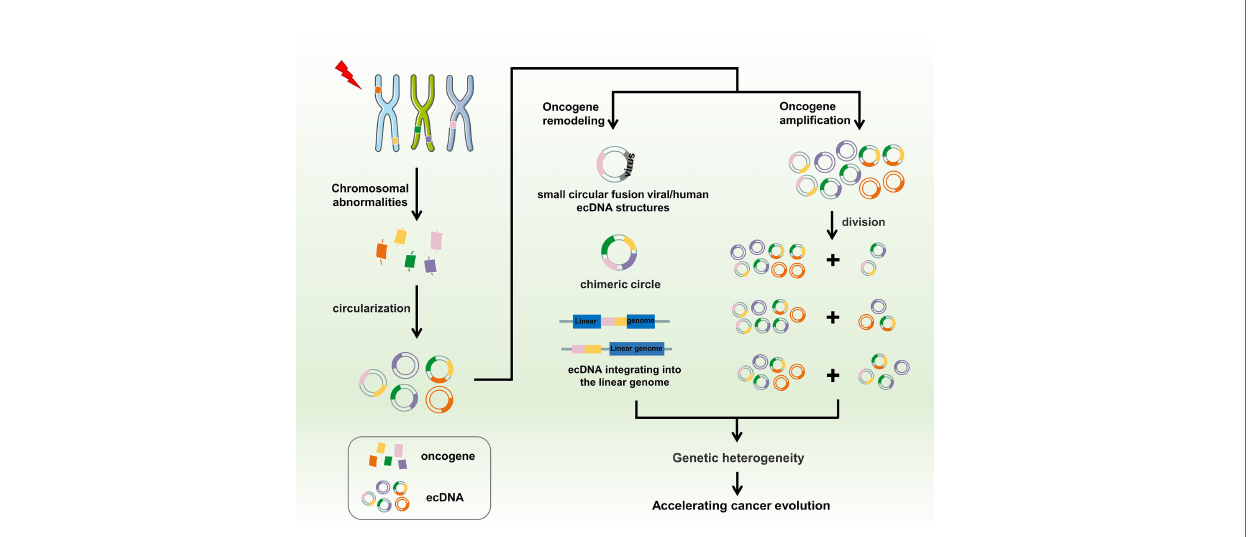
FIGURE 4 | EccDNA accelerates cancer evolution. Chromothripsis, genomic rearrangement, or other possible chromosomal abnormalities may cause DNA fragments to circularize to form eccDNA. EccDNA promotes oncogene remodeling through fusion with human viruses or chimeric circularization and reintegration of eccDNA into the linear genome, whereas ampli fi cation of oncogenes on eccDNA instead of chromosomes leads to higher copy numbers of these oncogenes in tumors. Moreover, eccDNA is randomly distributed to progeny cells during mitosis owing to the lack of centromeres. Ultimately, these processes promote genetic heterogeneity, further accelerating cancer